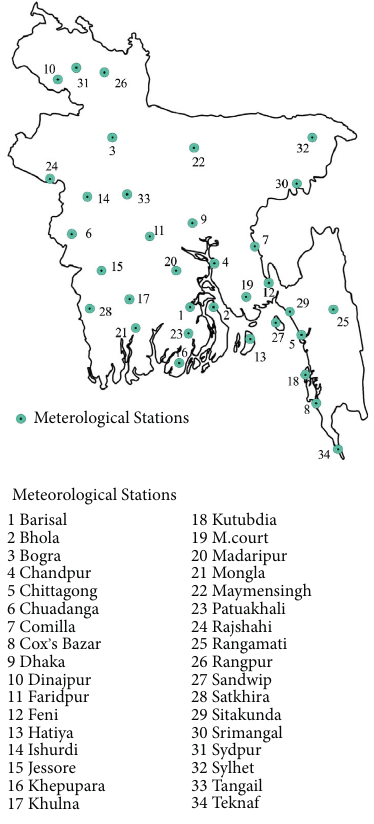
Figure 3: Location of 34 monitoring